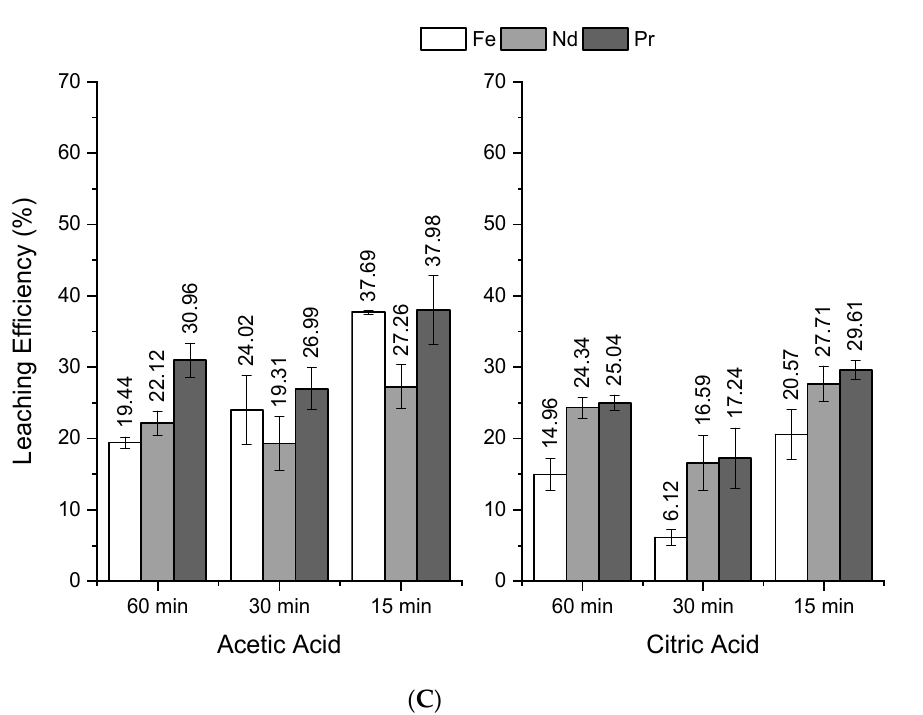
Figure 3. Comparison of the leaching efficiency of NdFeB magnets in acetic and citric acids, concen- tration 1 M, ratio s/l ( A ) 1/100; ( B ) 1/50 and ( C ) 1/10.